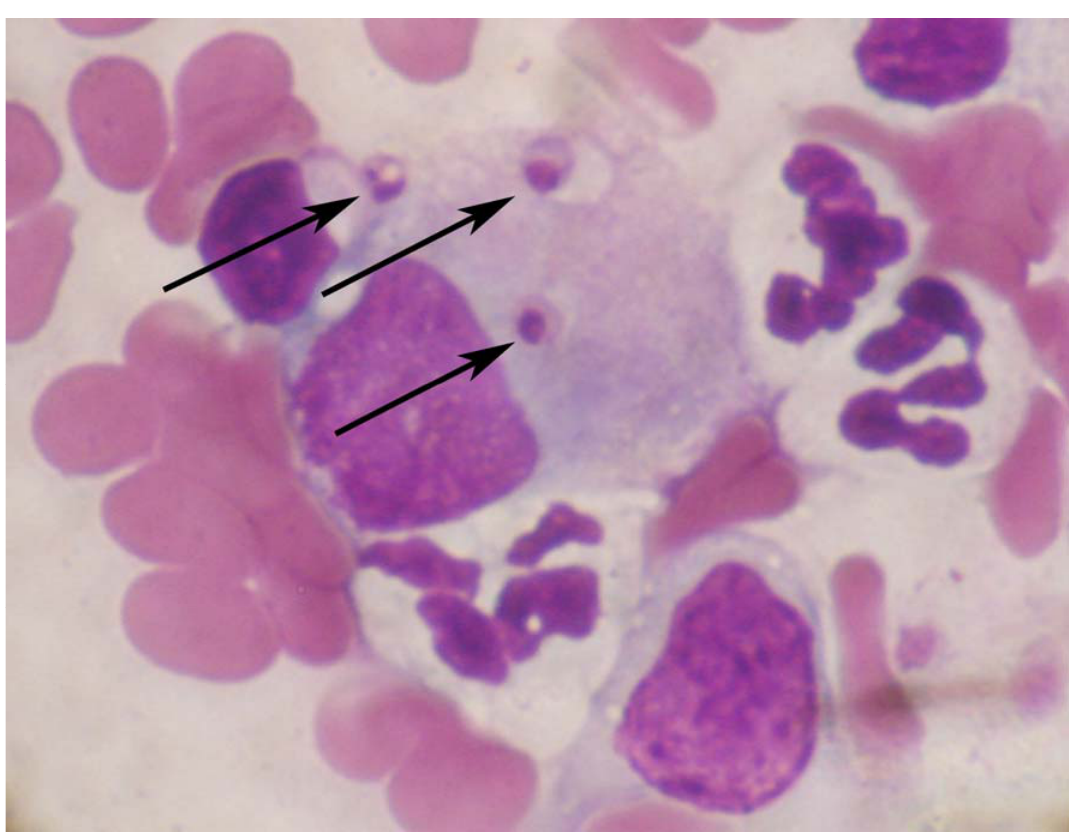
Figure 2. Extracellular and intracellular amastigotes found in smear from a lesion aspirate (arrows) from a feline infected with Leishmania (Leishmania) amazonensis